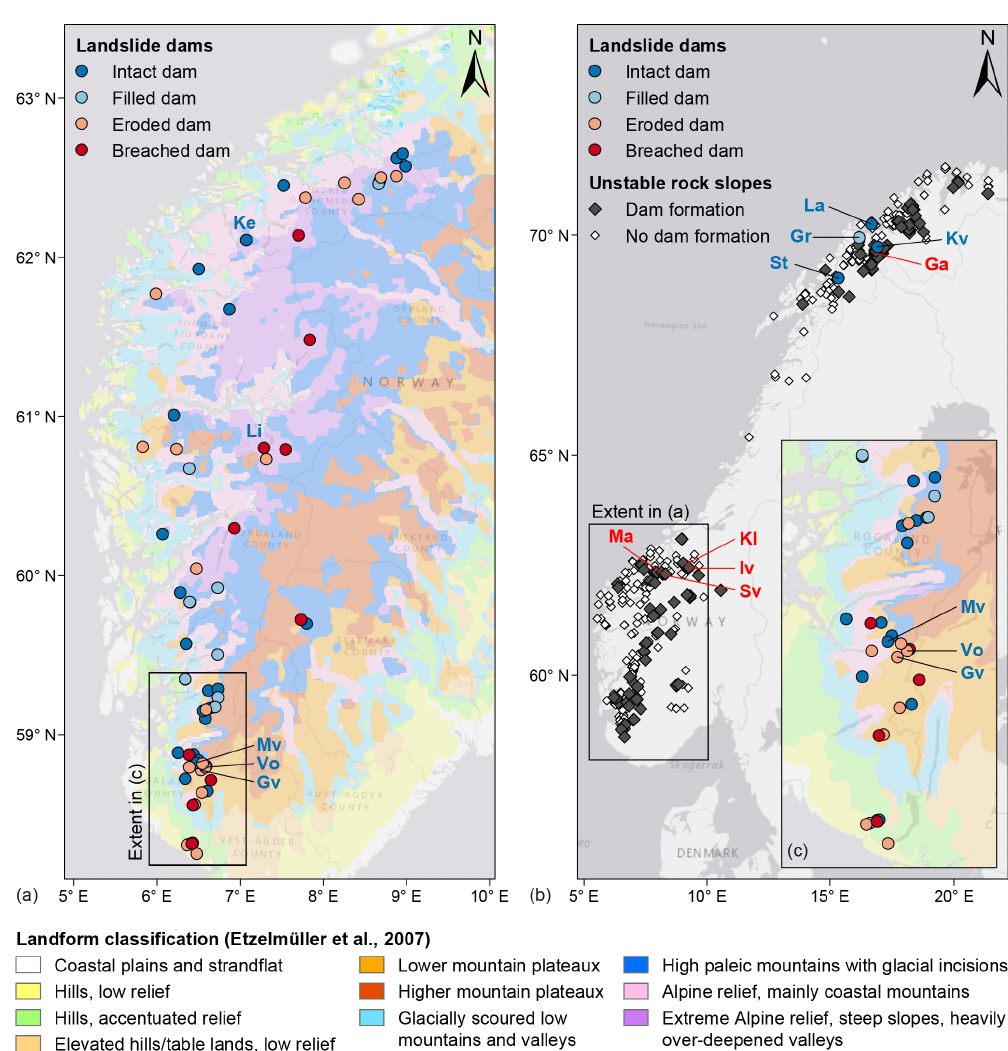
Figure 2. Inventory maps of dams from rock slope failures and unstable rock slopes in Norway: (a) dam inventory of southwestern Norway classified according to dam stability (modified from Jakobsen, 2015) underlain by the landform classification by Etzelmüller et al. (2007); (b) overview map of unstable rock slopes in Norway (per December 2019) that may lead to a rockslide dam in the case of catastrophic failure (data from NGU, 2020), along with the location of existing dams in northern Norway used as a validation dataset; (c) zoom on the rockslide dam clusters in Rogaland County. Rock avalanche dams discussed in the text are as follows (in blue font). Ke: Keipen; Li: Lintuvatnet; Mv: Månavatnet; Vo: Vondalona; Gv: Gautøynvatnet; La: Langfjordura; Gr: Grøtnesura; Kv: Kvarteurda; St: Steinura. Unstable rock slopes mentioned in the text are as follows (in red font). Ga: Gamanjunni; Iv: Ivasnasen; Kl: Klingråket; Ma: Mannen; Sv: